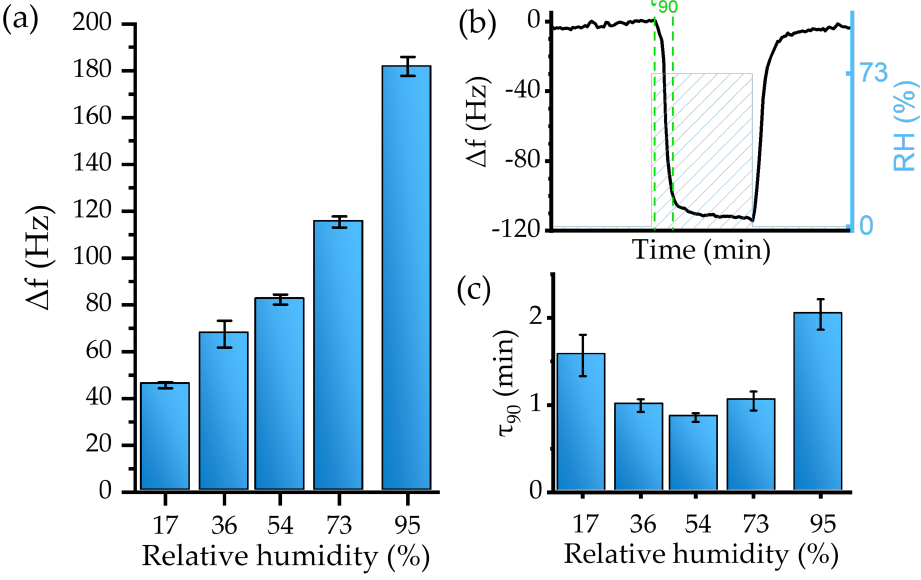
Figure 9. ( a ) Calibration curve, ( b ) τ 90 calculation method, and ( c ) τ 90 values for the sensor humidity